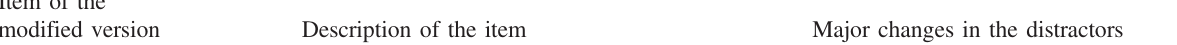
TABLE IX. Description of the modifications and the reasons behind these modifications in the items with major changes in the distractors (items 2, 7, 11, 12, 15, 18, 19 & 24; see Table III). Note that in this group of items, twelve major changes in the distractors were made.